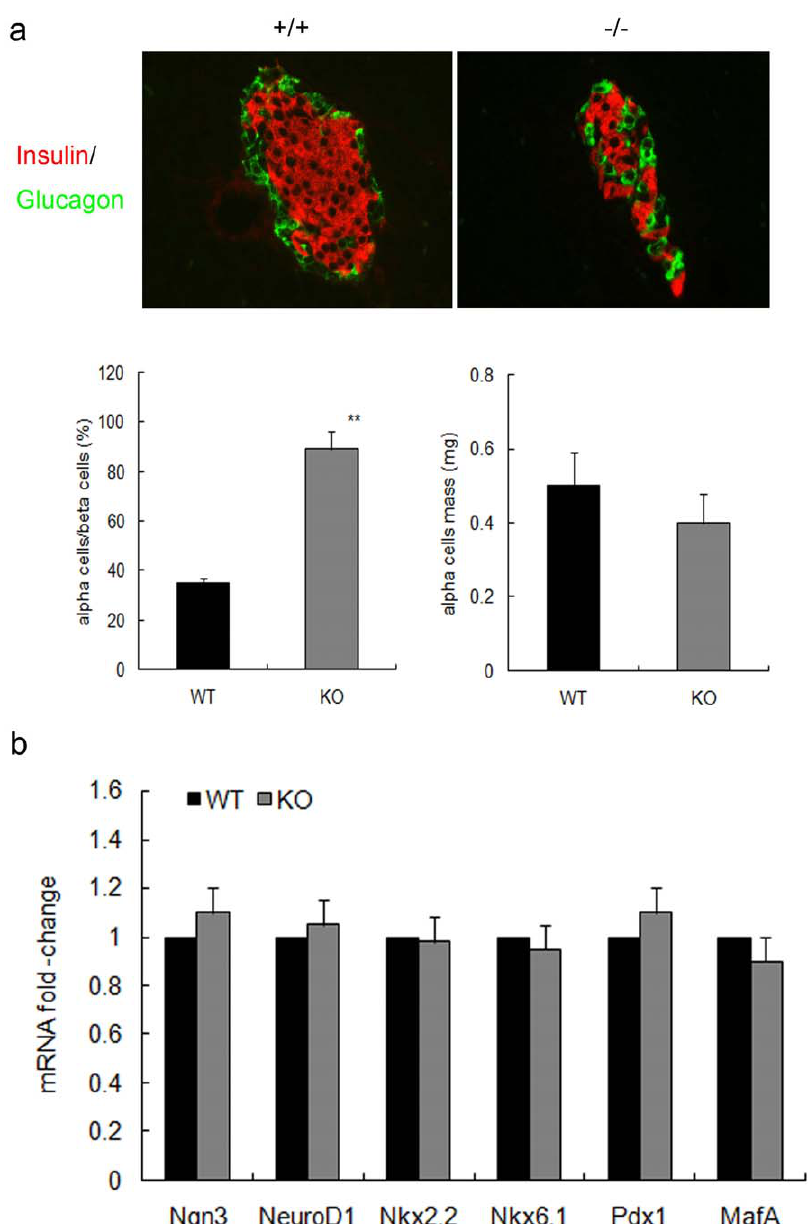
Figure 6. Islet development in RIPcre + survivin fl/fl mice and controls after PDL. (a) In day 7 PDL pancreas, insulin and glucagon positive cells show abnormal distribution in the mutant mice (upper panel, original magnification, 6 400). Quantification reveals that the knockout islet has a markedly higher proportion of alpha cells to beta cells as compared with controls (lowerleft panel). But alpha cell mass is similar in the two groups (lower right panel) (n=5 per genotype). (b) Fold change in the expression of the indicated genes related to islet neogenesis as determined by quatitative PCR are similar in day 7 PDL pancreas in the mutant mice (gray bars) compared with controls (black bars) (n=5 per genotype). WT, wildtype; KO, knockout. The data represent as means 6 SE. **p , 0.01 vs control.